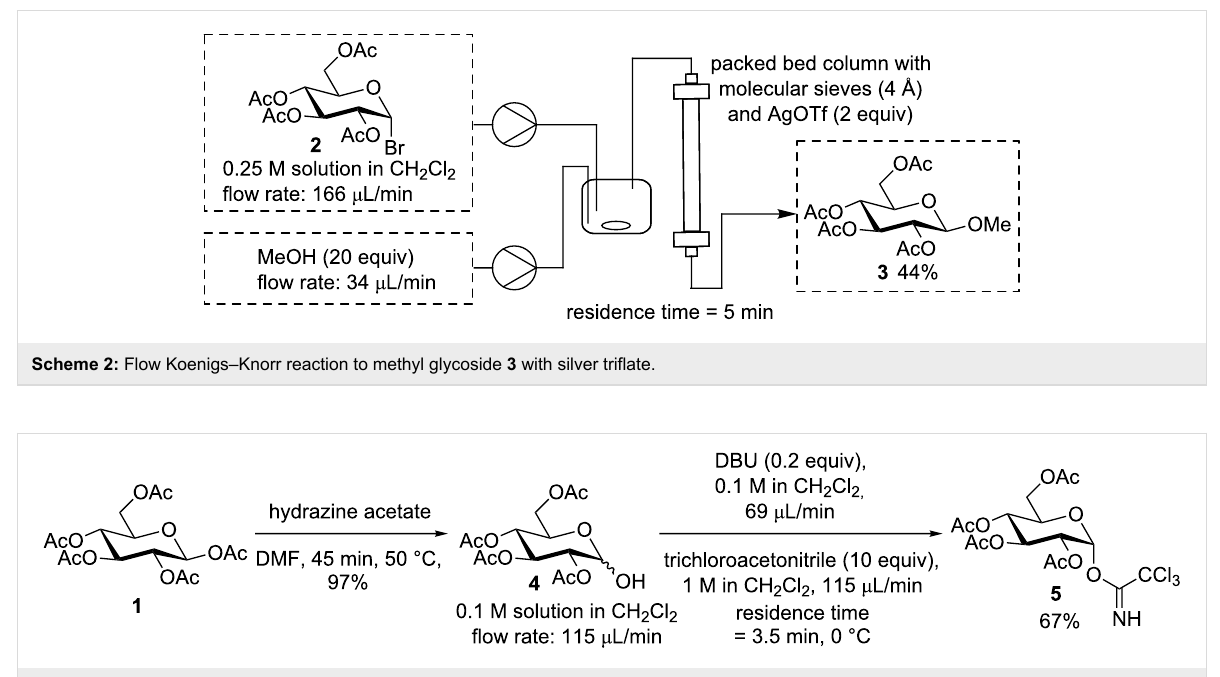
Scheme 3: Preparation of glycosyl donor 5